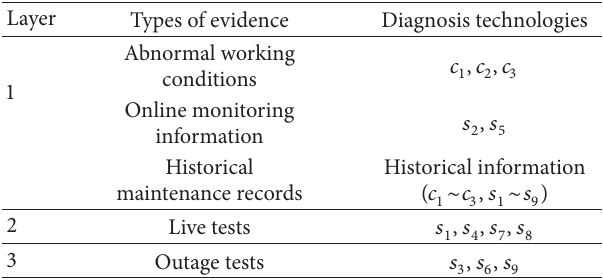
Table 3: Evidence division from an economic point of